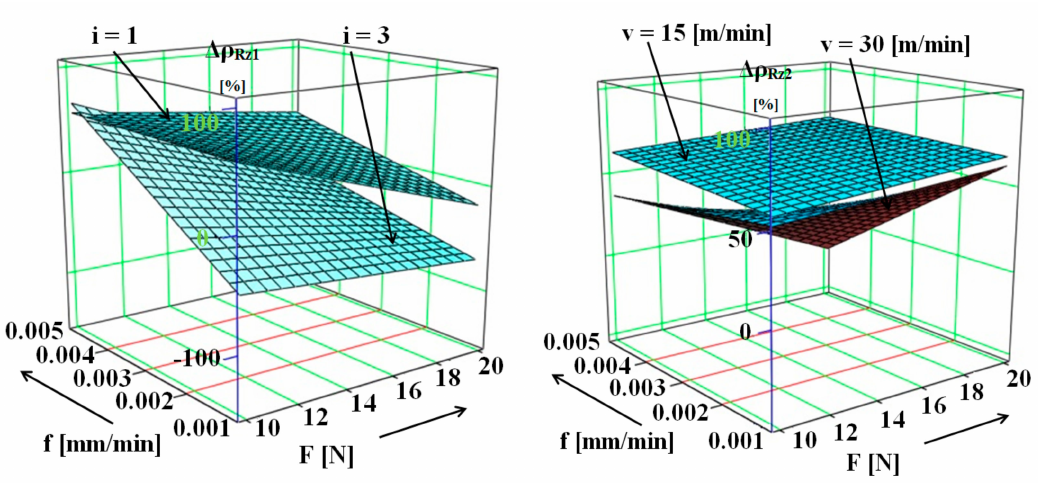
Figure 4. Changes in R q for Experiment I ( left ) and Experiment II ( right ).